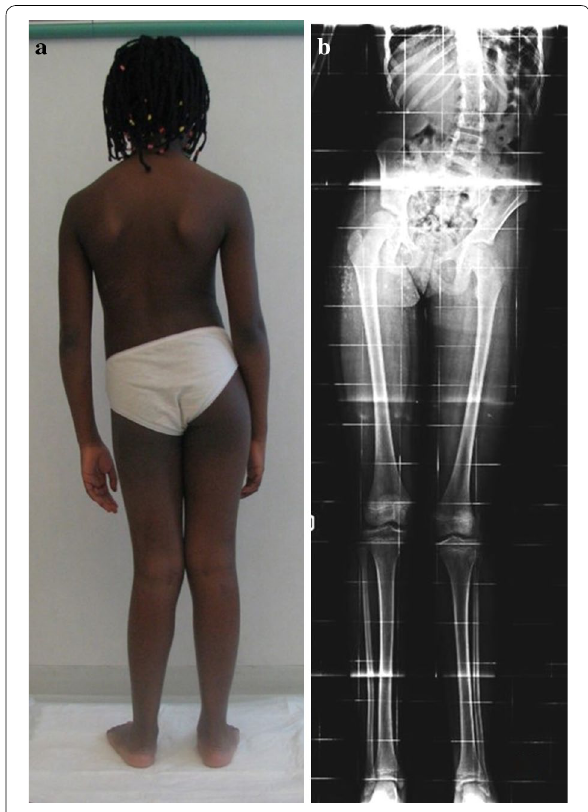
Fig. 2 a , b Clinical and radiographic aspect of congenital lower limb length discrepancy in a 10-year-old patient. The length inequality was 5.2 cm for the left femur and 1.4 cm for the tibia